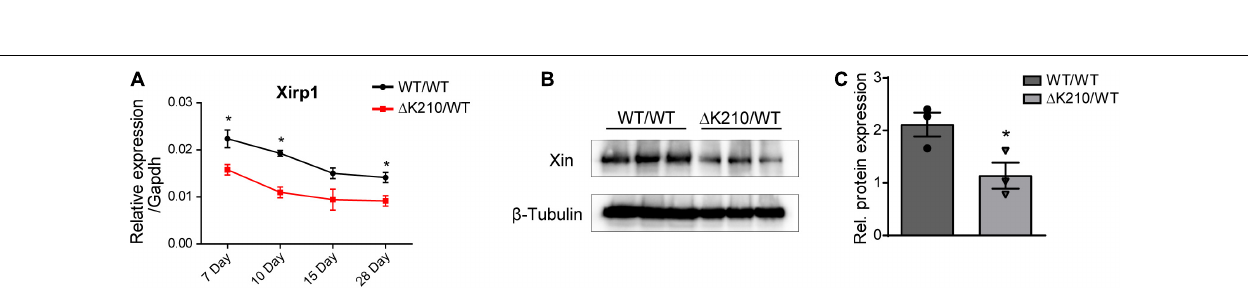
Frontiers in Cell and Developmental Biology |